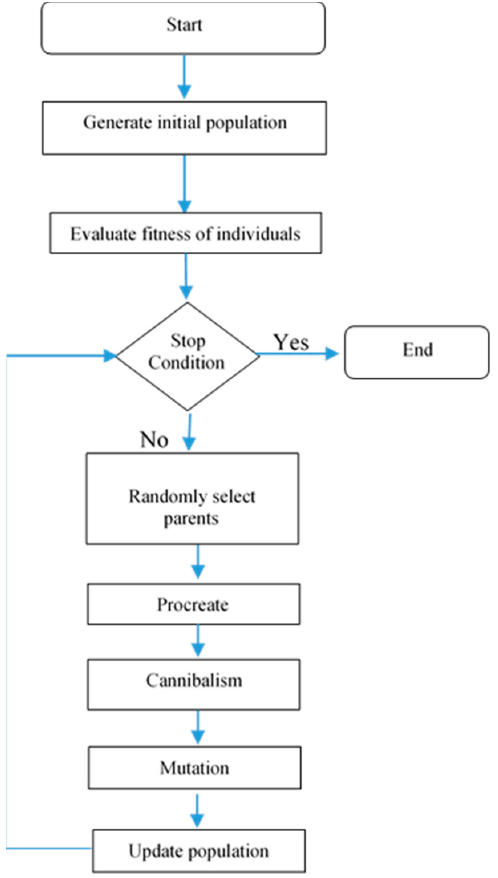
Figure 9. Black widow flow chart.